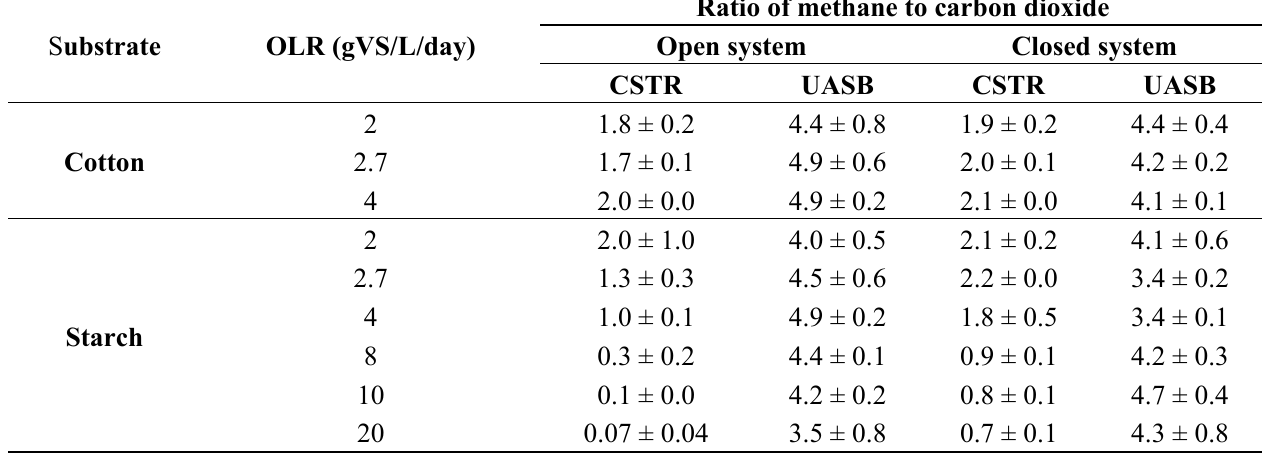
Table 3. The Ratio of methane to carbon dioxide, in open and closed system, for cotton and starch in UASB and